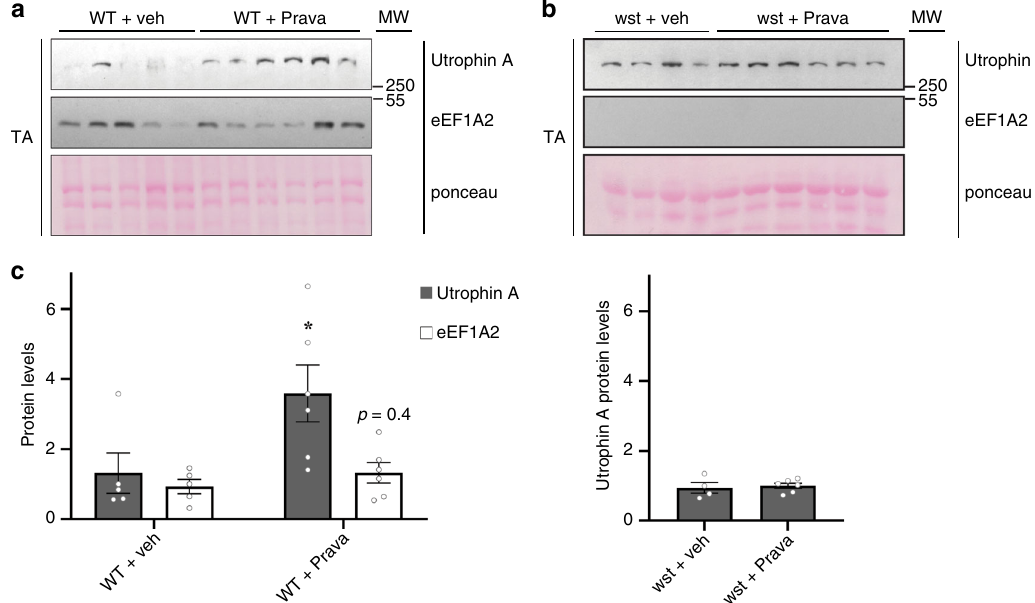
Fig. 7 Pravastatin does not induce a utrophin A increase in eEF1A2-null mice. eEF1A2-null mice (wasted mice — wst) and wild-type mice (WT) were treated with Pravastatin (Prava) (2 mg/kg) or saline for 5 days. a , b Western blots of utrophin A and eEF1A2 protein levels using protein extracts from TA muscles from wild-type and wasted mice treated with pravastatin or vehicle control. c Quanti fi cation of utrophin A and eEF1A2 protein levels normalized to ponceau in treated WT and wasted mice. N = 4 for WT or wst + veh and N = 6 for WT or wst + Prava. Error bars represent SEM, * P < 0.05, signi fi cantly different from vehicle control. Two-tailed Student's t -test was performed to determine statistical differences. Source data are provided as a Source Data fi